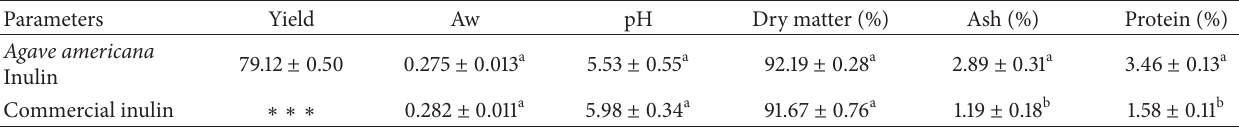
Table 2: Physicochemical properties of inulin obtained from Agave americana L. and commercial inulin (% DM). Parameters Yield Aw pH Dry matter (%) Ash (%) Protein (%) Agave americana 79.12 ± 0.50 Inulin Commercial inulin ∗ ∗ ∗ 0.282 ± 0.011 a 1.58 ± 0.11 b Means in the same column with different letters are significantly different ( 𝑃 < 0.05 ). Table3:Functionalpropertiesof Agaveamericana L.leavespowder , inulinextractedfrom Agavesamericana ,andcommercialinulinobtained by lyophilisation. Parameters Agave powder Commercial